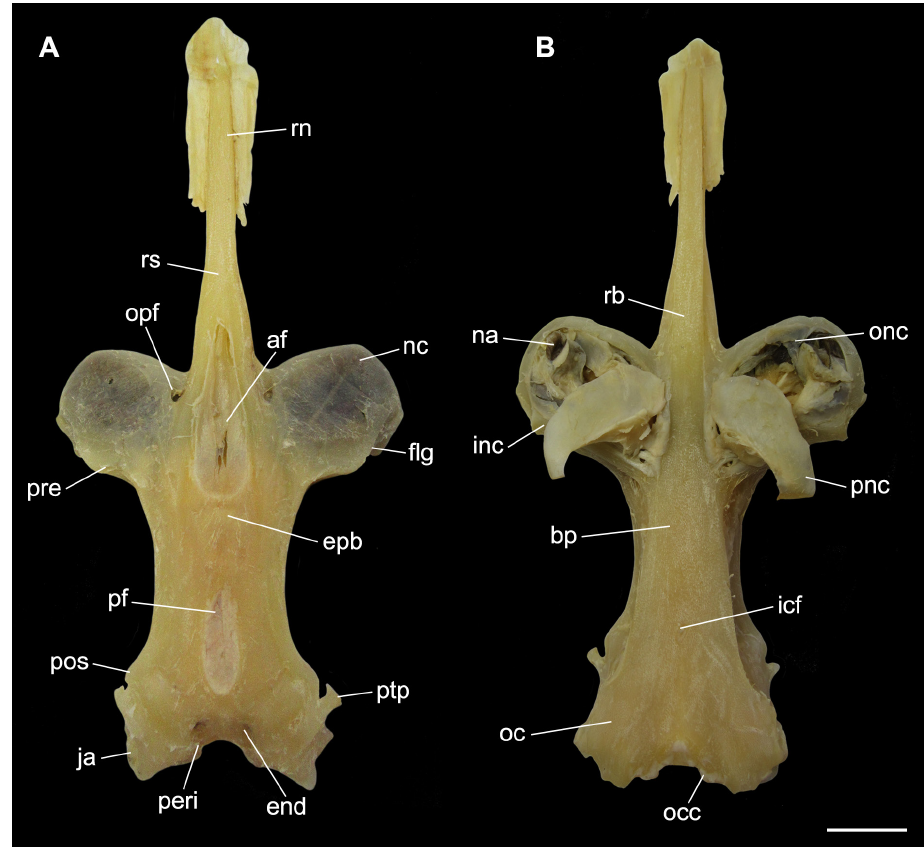
FIGURE 9 | Neurocranium of Atlantoraja cyclophora , MNRJ 117184, female, 583 mm TL. A. Dorsal view. B. Ventral view. af , anterior fontanelle; bp , basal plate; end , endolymphatic foramen; epb , epiphysial bridge; flg , flange; icf , internal carotid artery foramen; inc , inner nasal cartilage ja , jugal arch; na , nasal aperture; nc , nasal capsule; oc, otic capsule; occ , occipital condyle; onc , outer nasal cartilage; opf, ophthalmic foramen; peri , perilymphatic foramen; pf , posterior fontanelle; pnc , posterior nasal cartilage; pos , postorbital process; pre , preorbital process; ptp , pterotic process; rb , rostral base; rn , rostral node; rs , rostrum. Scale bar = 10